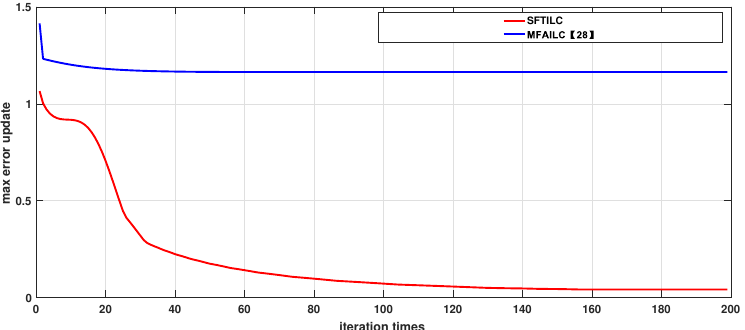
Figure 5. Maximum tracking